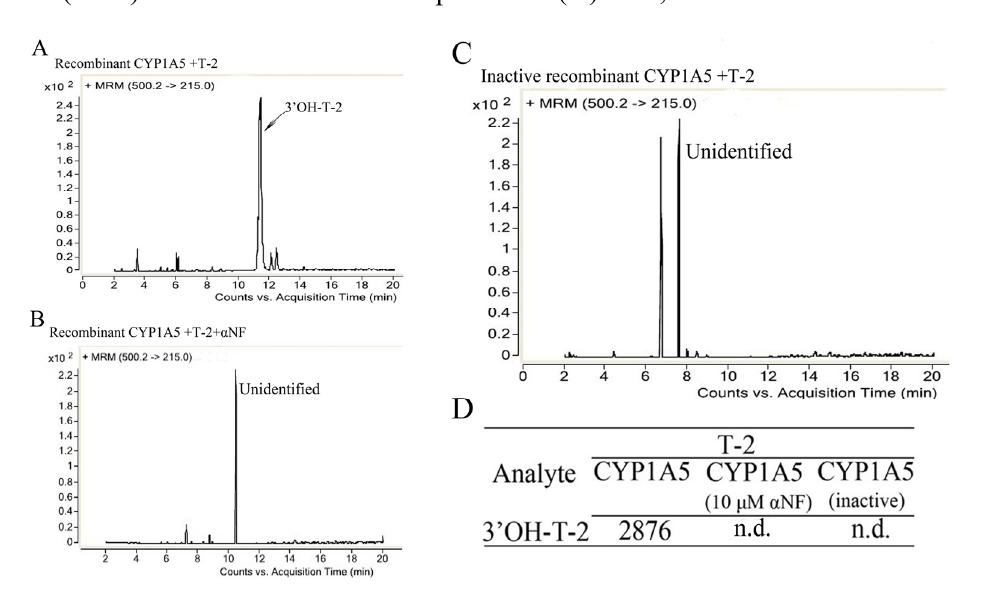
Figure 5. LC-MS/MS assays of T-2 after recombinant CYP1A5 biotransformation. T-2 was incubated with CYP1A5 (active or inactive) and in the reactions containing α NF or not. T-2 and its metabolites were detected and analyzed by LC-MS/MS. The data are represented as a spectrum ( A – C ) and as the values of the peak area ( D ). n.d., not